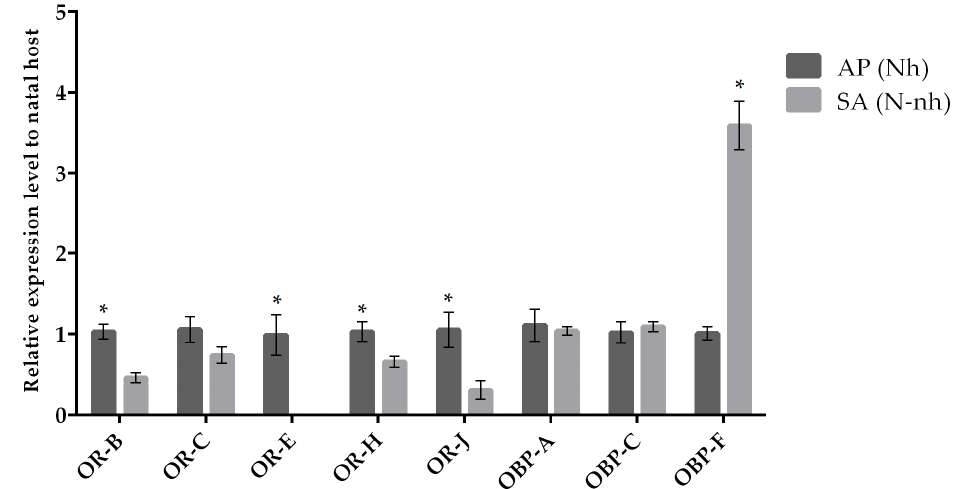
Figure 1. Mean (+/ − SE) mRNA expression levels of ORs and OBPs from the heads of A. ervi maintained on the natal host A. pisum (AP; Nh) or on the non-natal host S. avenae (SA; N-nh) measured by RT-qPCR. RT-qPCRs were performed using specific primers for each gene. Normalizer gene: RPL19. The asterisk * above the bars indicates significant differences according to two-way ANOVA ( p value < 0.05).